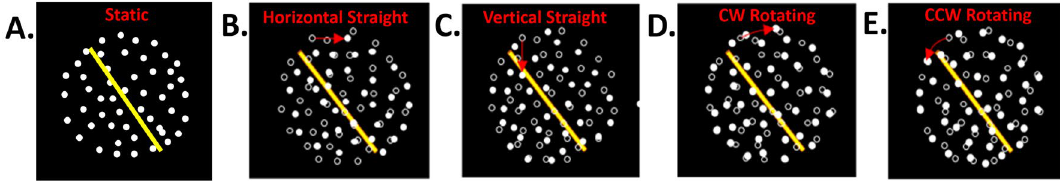
Figure 1. Visual stimulations. Visual stimulations consisted of one static visual stimulation and four directional structured optic flow. Static visual stimulation with the same background dot patterns of directional optic